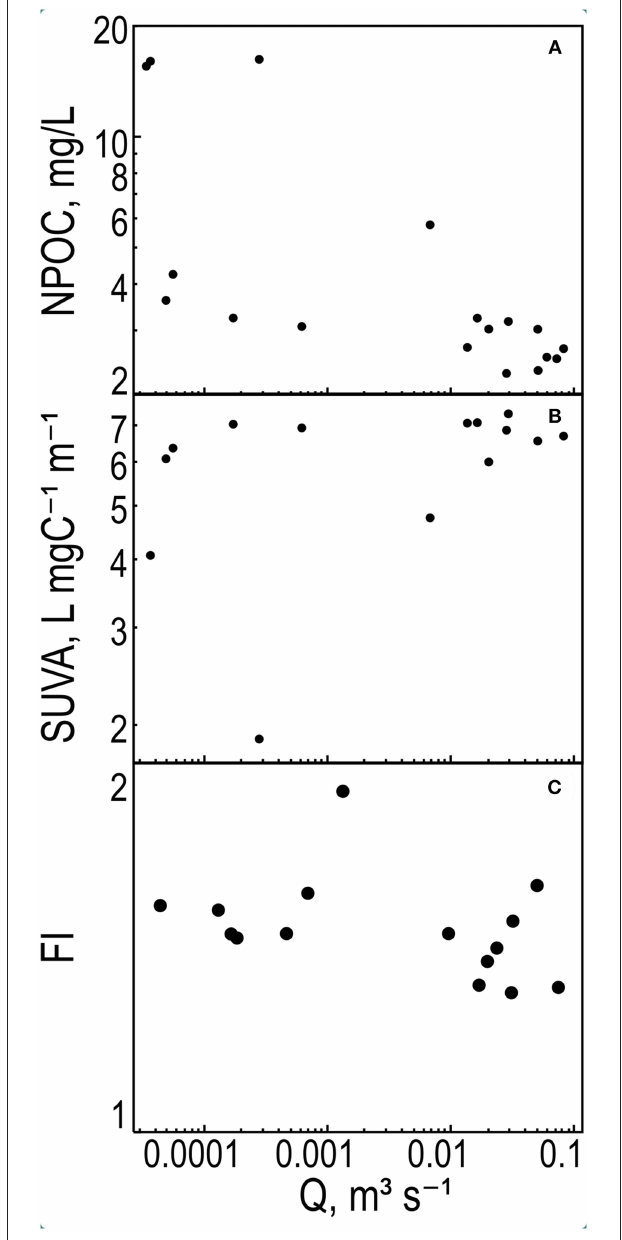
FIGURE 6 | Discharge at the outlet to RME, plotted in log-log space against (A) concentration of dissolved organic carbon, (B) SUVA, and (C) FI. DOC is highly variable at low flows and exhibits slight dilution at high flows, SUVA increases with Q, and FI remains relatively unchanged. Two outliers are not plotted here to facilitate visual comparison among all other samples: one snow sample with a very high FI and one bog piezometer samples with a very high SUVA. Insufficient sample was available to run the latter for